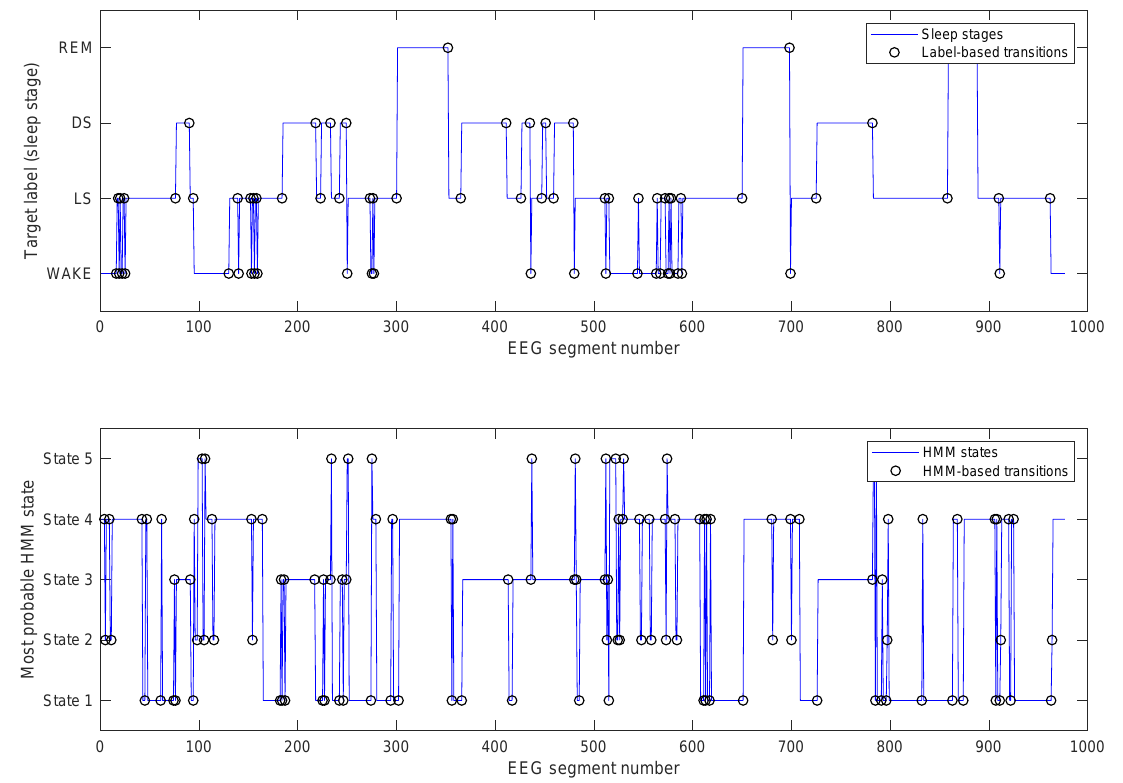
Figure 1. The difference between sleep stage sequence called hypnogram (top) and most probable state sequence of trained hidden Markov model (bottom). The label-based transitions must be be computed from the labels (sleep stages), which are not available in the active learning scenario. On the other hand, HMM-based transitions can be computed from the most probable state sequence of the HMM trained on feature time